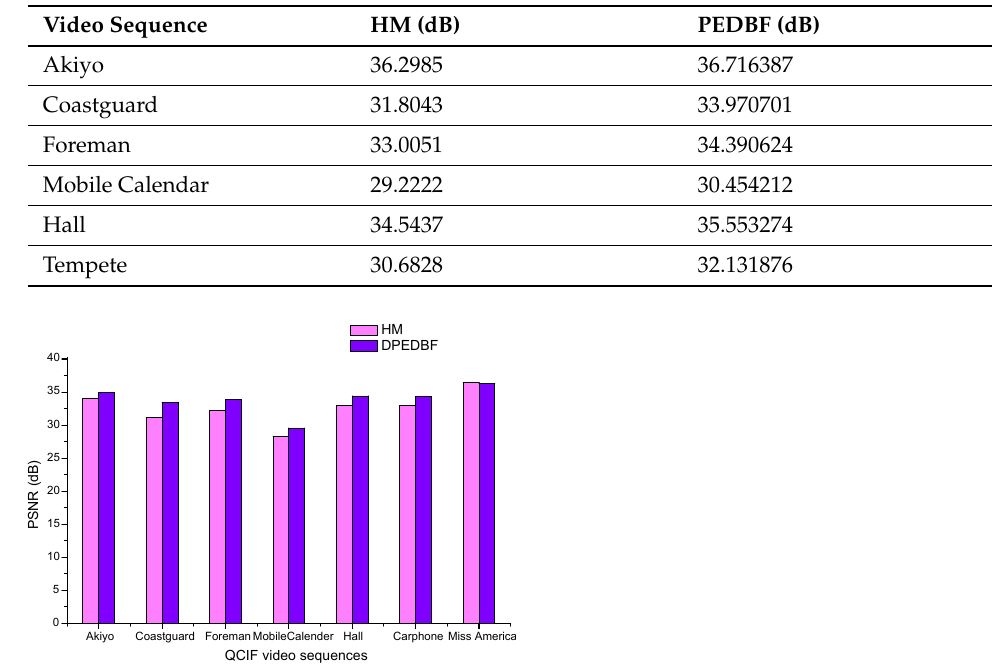
Figure 21. Comparison of PSNR with HM for QCIF video sequences using QP = 37.